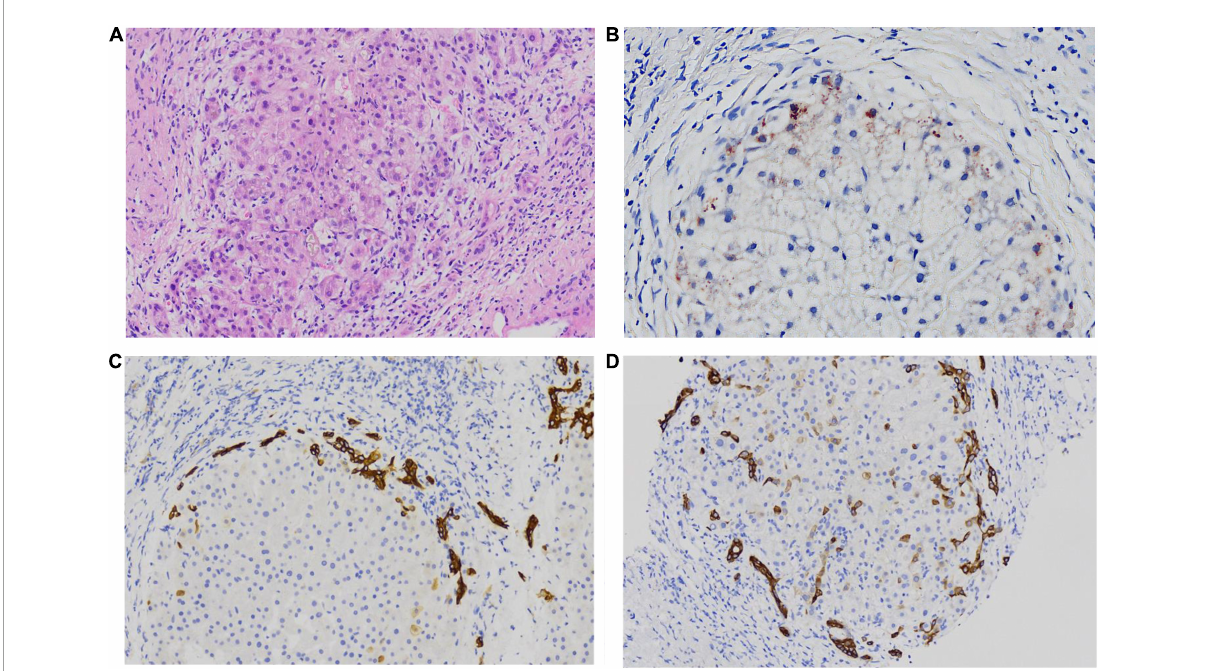
FIGURE2 some special pathologic features of patients with PFIC3 in liver biopsy specimens. Panel (A) shows the presence of bile plugs in some ductules and lobules with hepatocyte cholestasis; Panel (B) shows orange granule deposits of copper in periportal hepatocytes (Rhodamine staining). Panel (C) shows immunohistochemical staining for cytokeratin 7 (ck7), which confirms the presence of interlobular duct and ductular reaction. Panel (D) shows the heterotopic expression of ck7 on periportal hepatocytes, indicating chronic cholestasis. Panels (A,B) show H&E-stained samples; Panels (C,D) show immunohistochemically stained samples; magnification: 200 × in (A–D) .